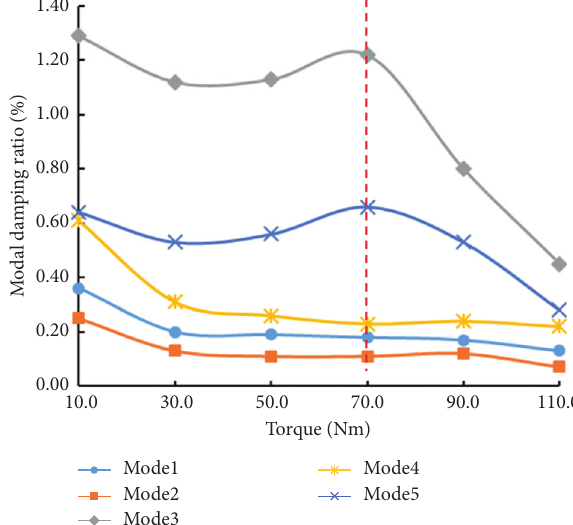
Figure 5: Modal testing results of Case 1: modal frequency versus preload on M16 bolt.